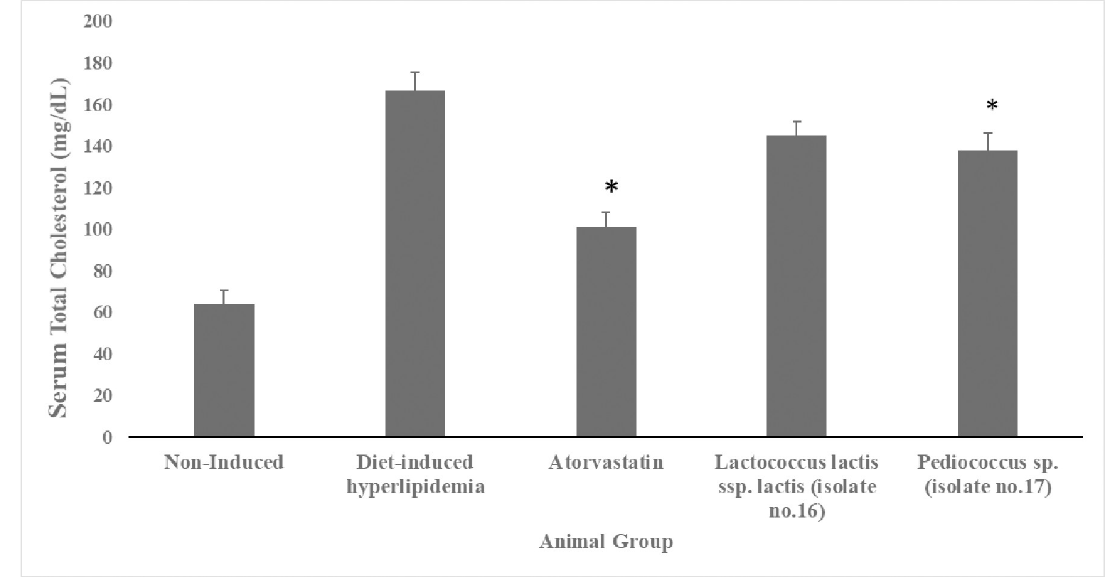
Fig 3. Serum total cholesterol levels (mg/dL) of hyperlipidemic hamsters. Non-induced group (standard food diet), diet-induced hyperlipidemic group (HFD-fed), Lactococcus lactis ssp. lactis group (HFD-fed + 1 × 10 9 CFU/mL /day), Pediococcus sp. group (HFD-fed + 1 × 10 9 CFU/mL /day) and atorvastatin group (HFD-fed + 1.23 mg/kg/day atorvastatin). Data are represented as the mean ± SEM (n = 6). Asterisks indicate a significant difference ( p < 0.05).